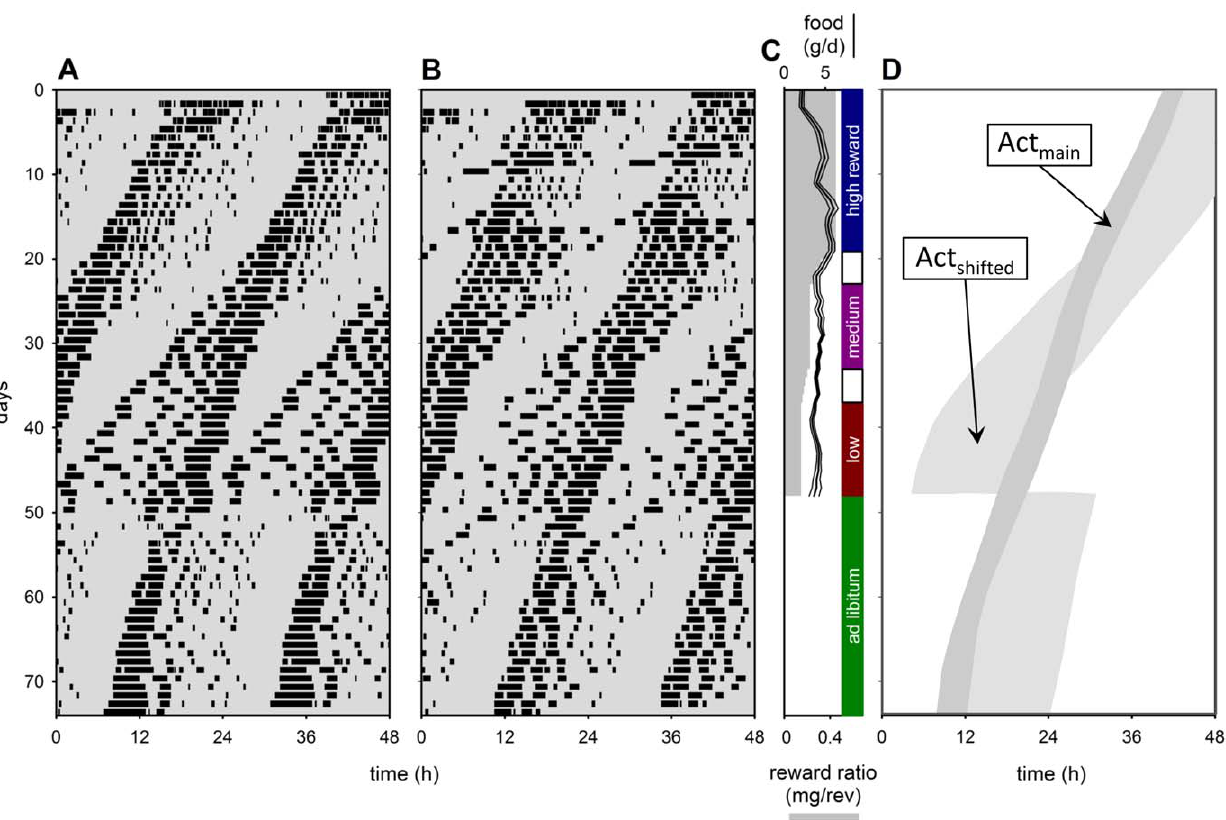
Figure 3. Reduced reward ratio modifies free-running circadian activity patterns in continuous dim light (DD). ( A , B ) Two examples of free-running activity rhythms in mice that work for food are shown in double plotted actogram format. ( C ) Gradual reward ratio reduction (grey bars) and food obtained (line, in g/d; thin lines indicate s.e.m.) shifted circadian activity patterns. ( D ) Graphical interpretation of observed activity patterns where a shifted activity component (Act shifted , light grey area) is discerned from a non-shifted main activity component (Act main , dark grey area). Four different work levels were applied: high reward ratio (C, blue bar), medium reward ratio (C, purple bar), low reward ratio (C, red bar), and ad libitum (C, green bar).